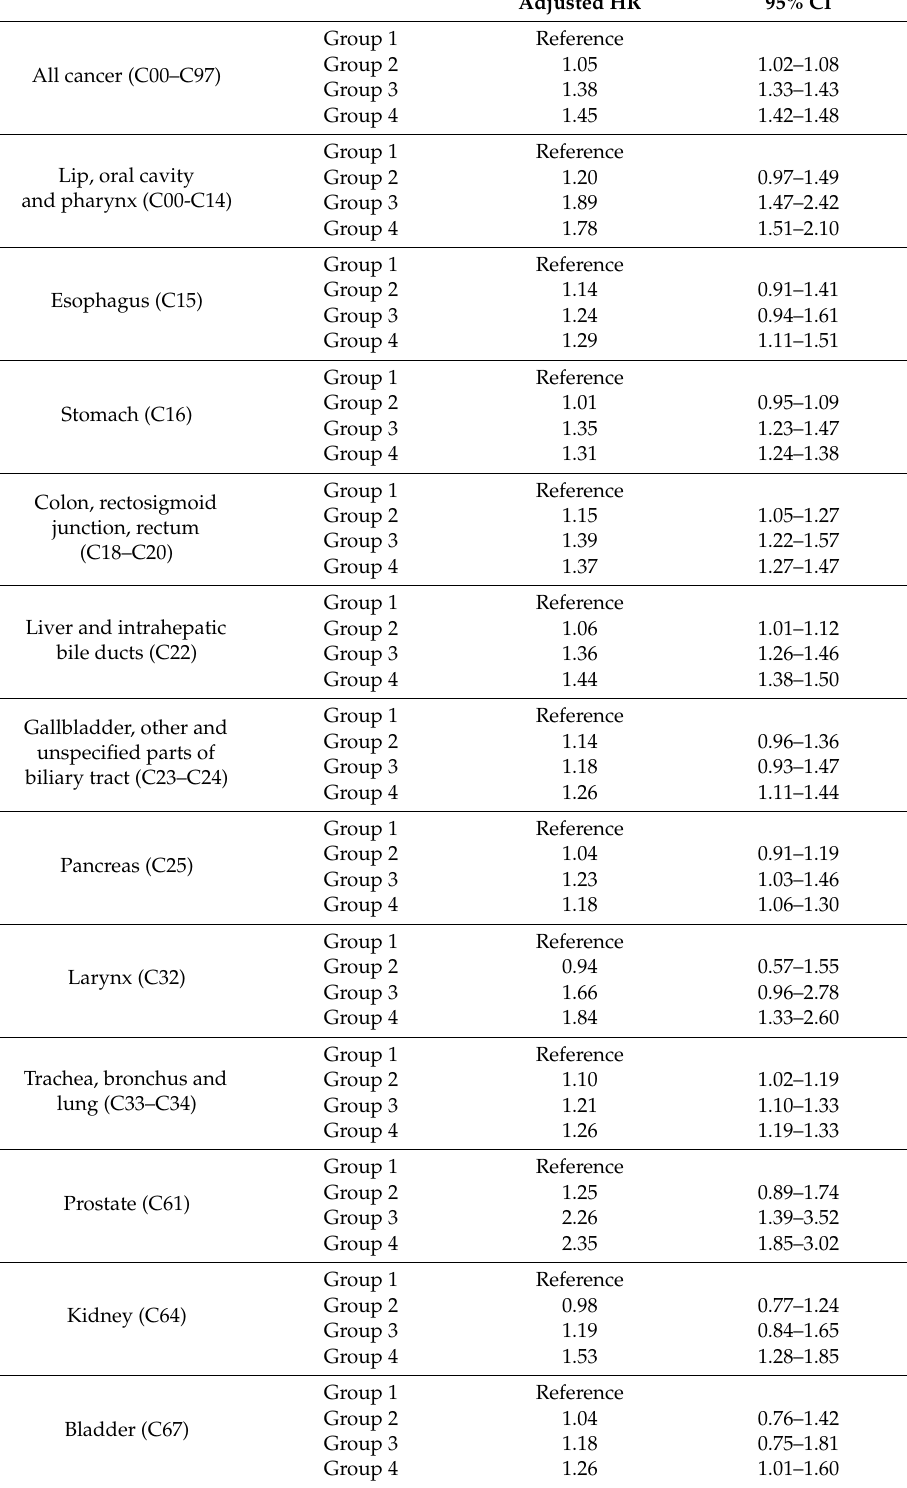
Table 3. Cancer specific HRs and 95% CIs according to occupational groups using Cox proportional hazard model adjusted for age and year of